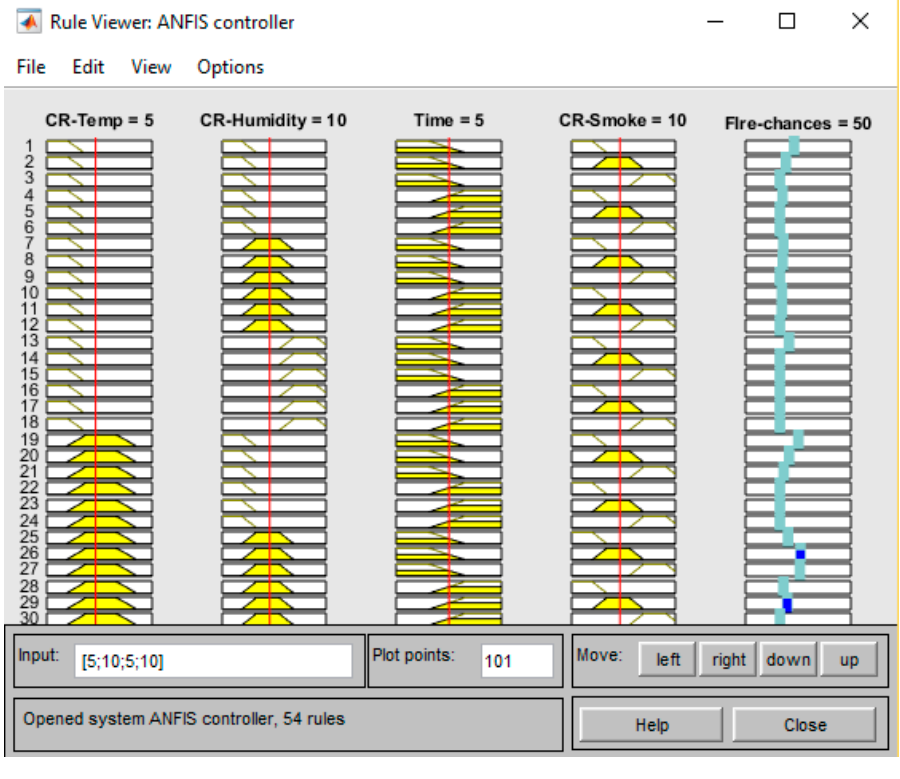
Figure 17. Fire-Chances with input variations.